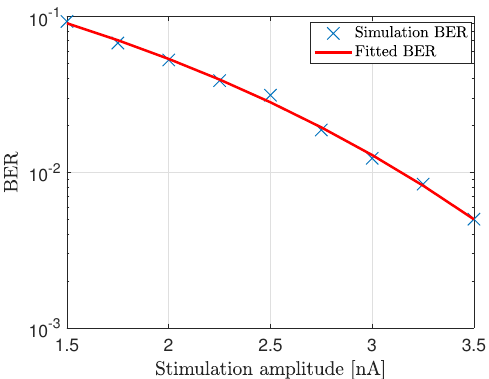
Figure 9. BER of the communication system where ten cardiomyocytes form the propagating